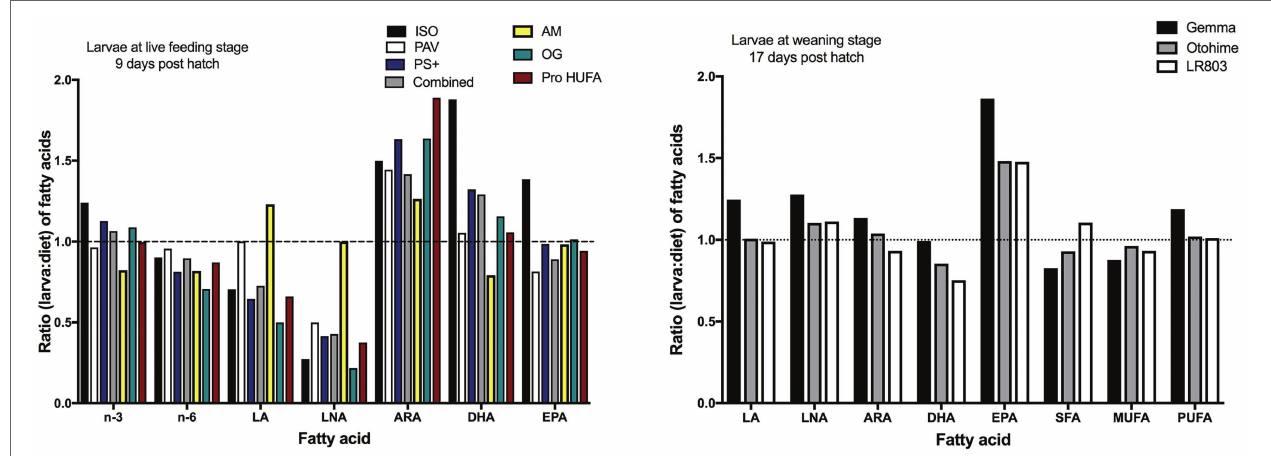
FIGURE 1 | Ratio (larva: diet) of fatty acids in Florida pompano ( Trachinotus carolinus ) larvae at the live feeding [9 days post hatch (DPH)] and the weaning period (17 DPH). Larvae at 9 DPH were fed several enriched rotifer diets: two microalga concentrates [ Isochrysis sp. (ISO) and Pavlova sp. (PAV)], a semi-moist paste [Protein Selco Plus (PS+)], a combination of the three (Combined), and three dry enrichment diets [AlgaMac 3050 (AM), Ori-Green (OG), and Protein highly unsaturated fatty acids (HUFA; PH); Cavalin and Weirich, 2009]. Larvae at 17 DPH were fed three microdiets [Gemma, Otohime, and a reference diet (LR803); Hauville et al., 2014]. The dashed lines (ratio = 1) indicate equal amounts of fatty acids in the larvae and in the diet. LA, linoleic acid; LNA, linolenic acid; ARA, arachidonic acid; DHA, docosahexaenoic acid; EPA, eicosapentaenoic acid; SFA, saturated fatty acids; MUFA, monounsaturated fatty acids; and PUFA, polyunsaturated fatty